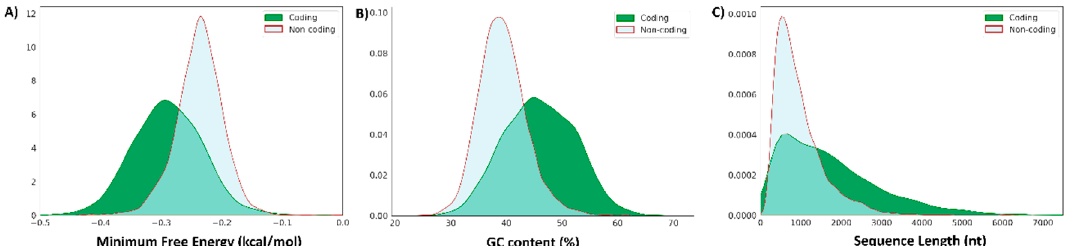
Figure 5. Distributions of length-corrected minimum free energy, content of guanine-cytosine (GC) base pairs and transcript lengths differ between protein coding transcripts (PCTs) and putative novel lncRNAs. ( A ) lncRNA transcripts have a higher mean length-corrected minimum free energy ( − 0.237 kcal/mol/nt) than PCTs ( − 0.289 kcal/mol/nt). ( B ) lncRNA transcripts have a lower mean GC base pair content (0.393) than PCTs (0.460). ( C ) Distribution of sequence lengths differ between lncRNAs and PCTs. Note that the distribution of PCT sequence lengths includes many longer sequence lengths.